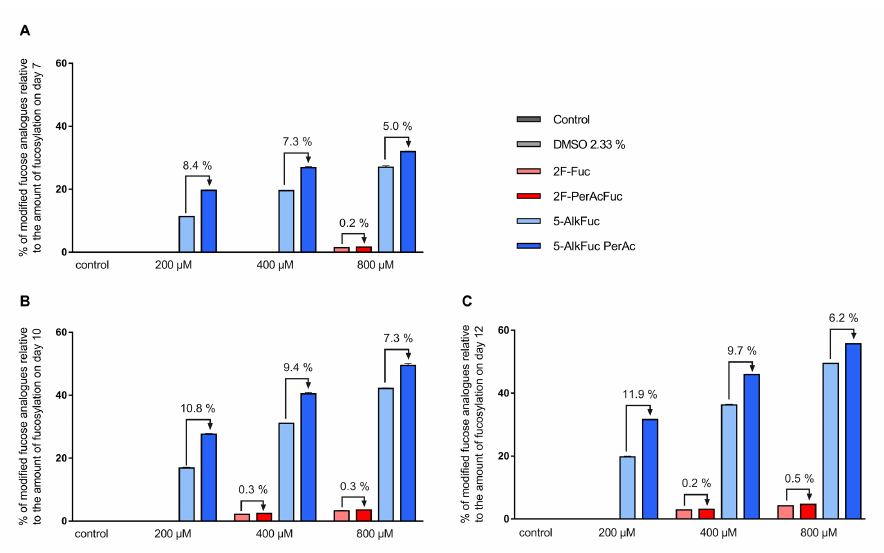
Figure 4. Relative incorporation of fucose analogues. Feed supplemented with fucose analogues was adjusted to 2.33% DMSO (except for the control) and added on day 3 (3%; v / v ) day 5, 7 and 10 (6%; v / v ). Glycosylation analysis on ( A ) day 7, ( B ) day 10 and ( C ) day 12 was obtained by UPLC-MS